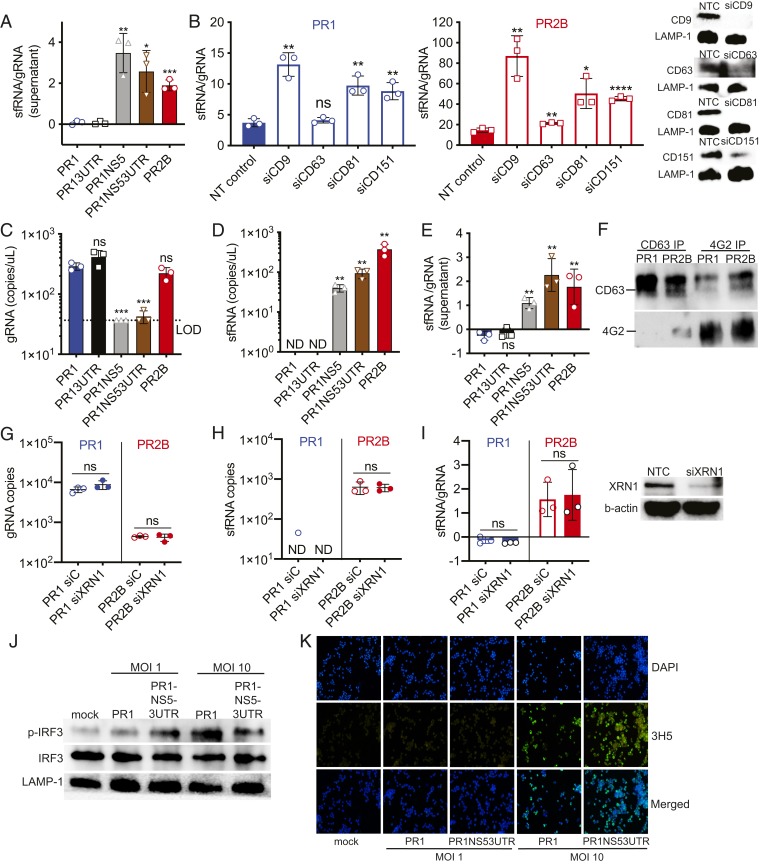
PR2B sfRNA is packaged inside E protein-containing infectious particles and transmitted into new susceptible cells. (A) Quantification of sfRNA:gRNA ratios in supernatant of A549 cells at 24 hpi by qPCR. (B) Quantification of gRNA:sfRNA ratios in supernatant of A549 cells on knockdown of CD9, CD63, CD81, and CD151. NTC served as a reference point for assessment of significance. (C–E) Quantification of gRNA copy numbers (C), sfRNA copy numbers (D), and sfRNA:gRNA ratios (E) from 4G2 pull-down precipitate. LOD, limit of detection; ND, no detection. PR1 served as a reference point for assessment of significance. (F) Western blots of CD63 and 4G2 in pull-down precipitate. (G–I) Quantification of gRNA (G), sfRNA (H), and sfRNA:gRNA ratios (I) in A549 cells at 2 hpi, after XRN1 knockdown. (J) Western blots of phosphorylated IRF3, IRF3, and LAMP-1 at 6 hpi with MOIs of 1 and 10 of mock, PR1, and PR1NS53UTR and cotreatment of NITD008. (K) Level of infection with MOIs of 1 and 10 of mock, PR1, and PR1NS53UTR quantified by immunofluorescence assay. Data are presented as mean ± SD. *P < 0.05; **P < 0.01; ***P < 0.001; ***P < 0.0001, unpaired t test. ns, not significant.